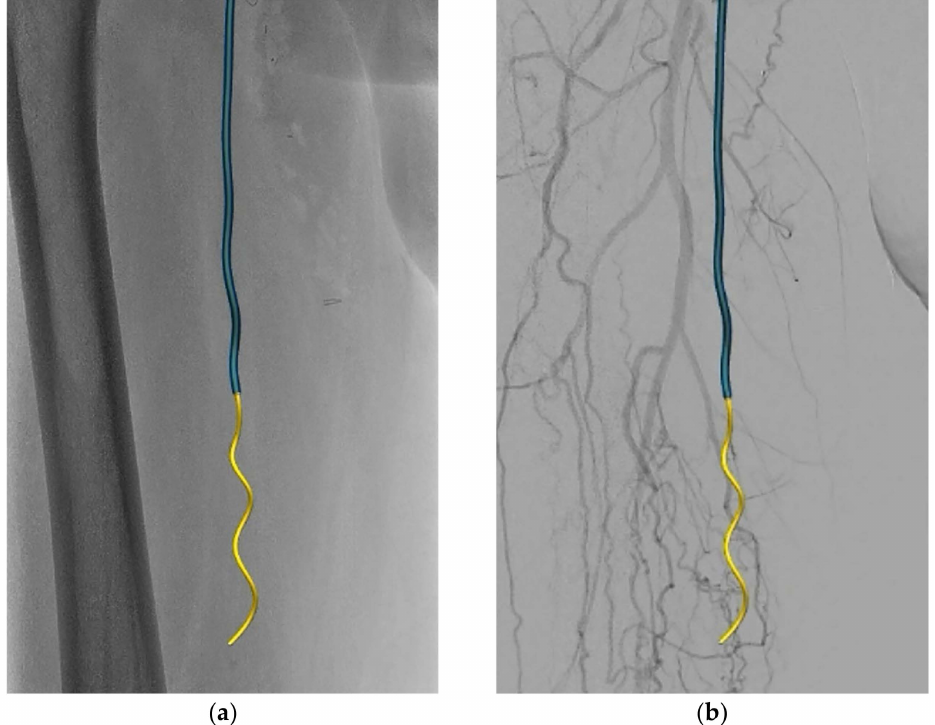
Figure 2. Overview of recanalization of the occluded SFA with fluoroscopic ( a ) and digital substrac- tion angiography (DSA) ( b ) background using 0.035 inch angled hydrophilic floppy Fiber Optic Realshape (FORS) enabled guidewire (yellow) and 5.5F FORS-Berenstein catheter (blue). The three- dimensional (3D) visualization of the FORS enabled guidewire clearly shows that the guidewire, with the tip pointing forward, slowly twisted subintimally around the occluded SFA like a